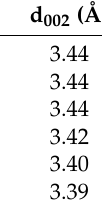
Table 1. Layer plane spacing of anthracene coke with respect to time above 2600 ◦ C. Time (s)